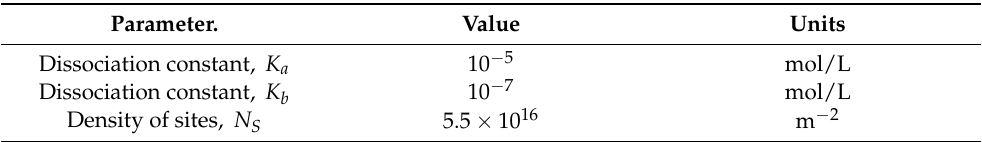
Table 1. Parameters values of the SB model for the Pt sensing layer, used to fit the experimental data shown in Figure 8.